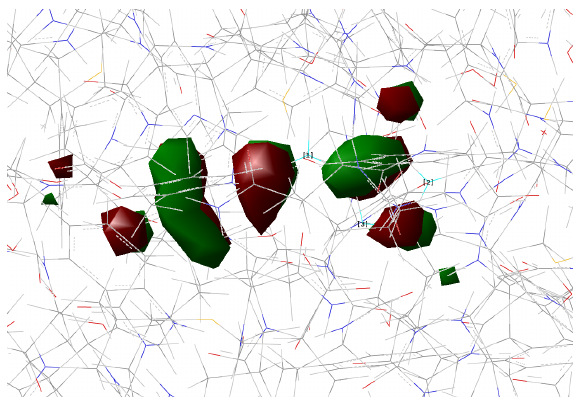
Figure 11. LUMO calculated for psamFP488 in Network1.